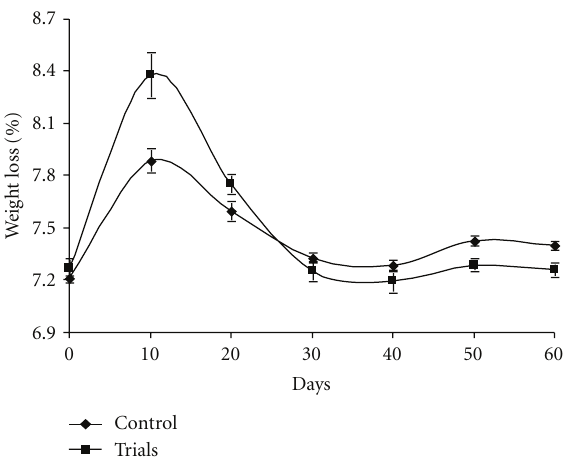
Figure 8: Variation of pH during the bioconversion of MSW.